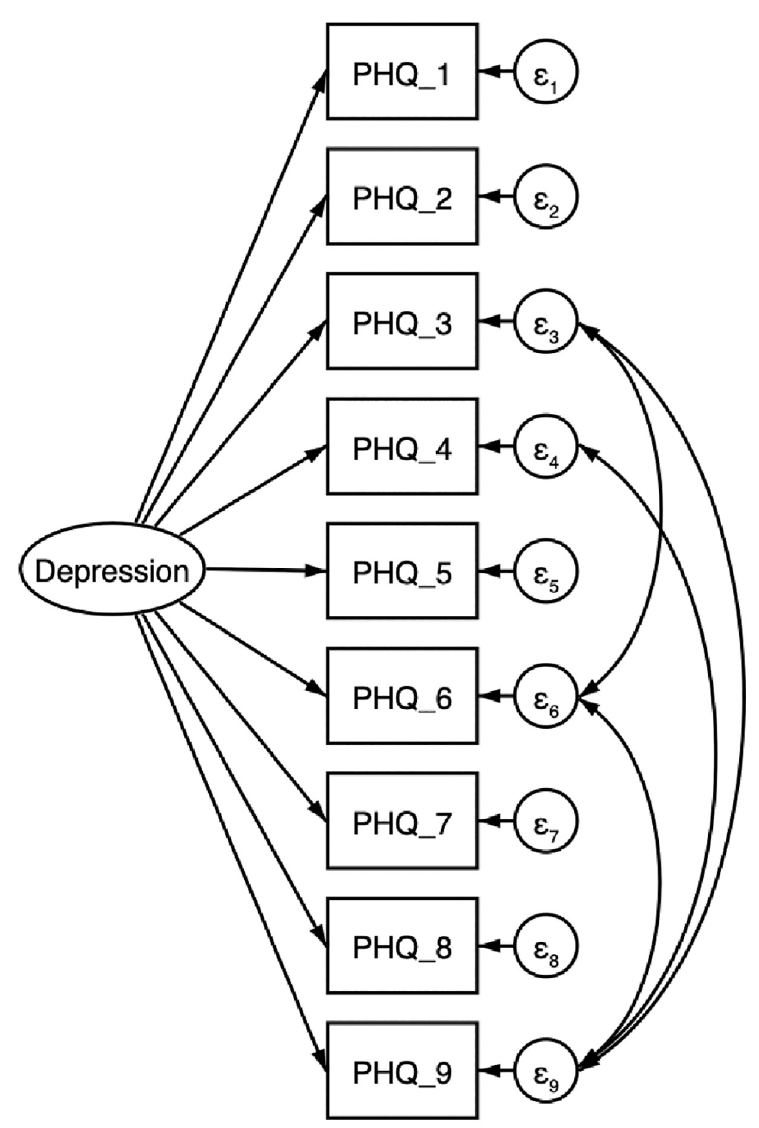
Fig 1. Confirmatory factor analysis path diagram for modified one-factor model of PHQ-9 factors. (All factor loadings and error covariances were significant at p < 0.001).